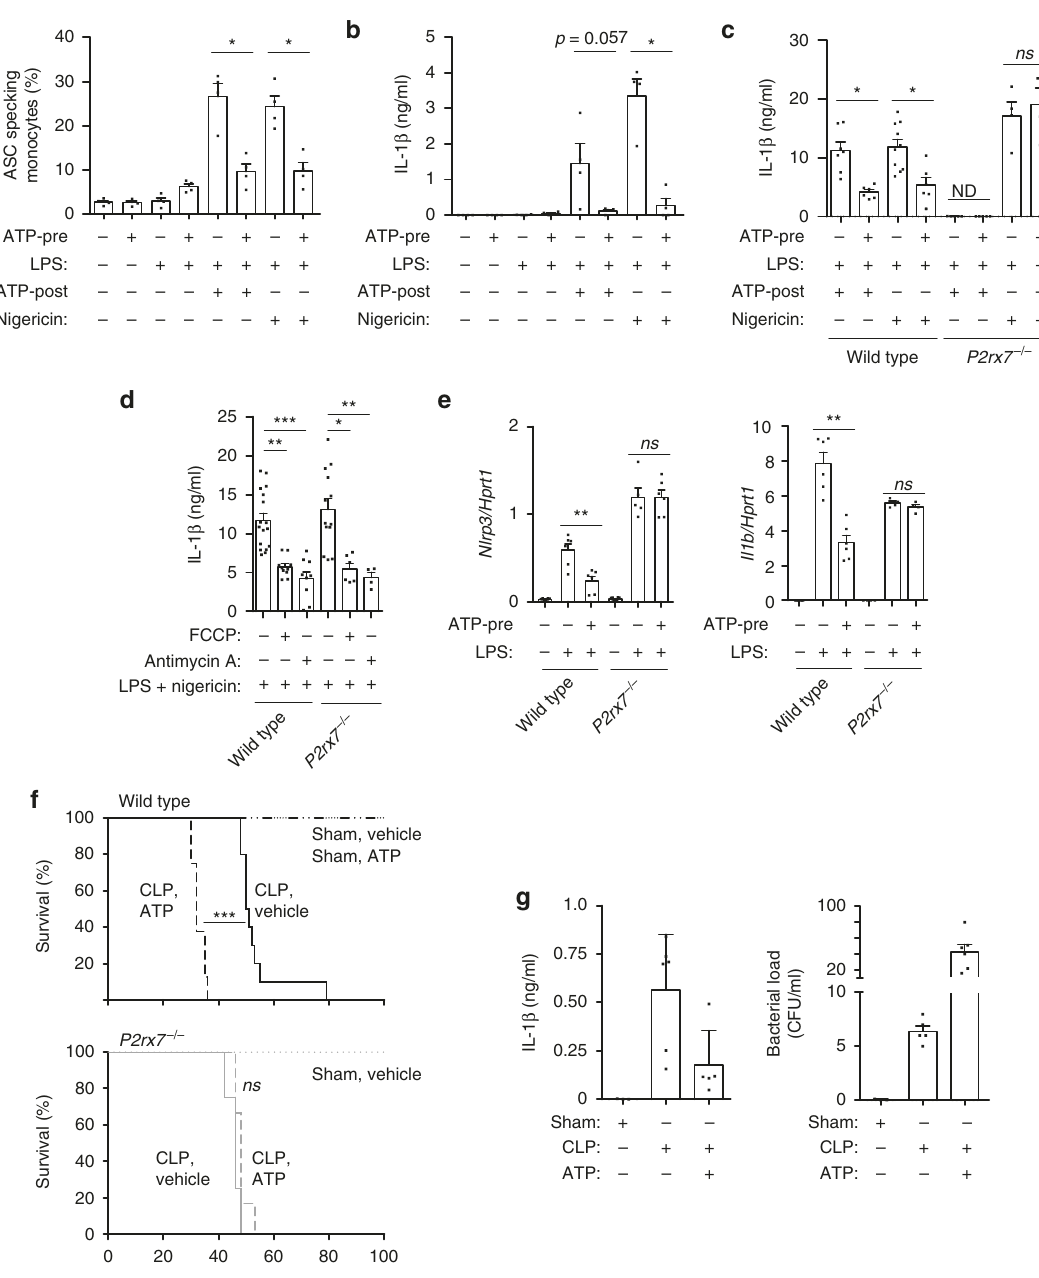
Fig. 6 P2X7 receptor stimulation impairs the NLRP3 in fl ammasome in monocytes. a , b Percentage of monocytes with ASC-specks ( a ) and release of IL-1 β from PBMCs ( b ) isolated from healthy donor blood samples treated with ATP (3 mM, 30 min; ATP-pre), then washed and primed with or without LPS (1 μ g/ml, 2 h) and then treated for 20 min with ATP (3 mM; ATP-post) or nigericin (10 μ M) as indicated. c IL-1 β release from wild type or P2rx7 − / − BMDMs treated as in a , but with 4 h LPS priming and 30 min of ATP or nigericin. d IL-1 β release from wild type or P2rx7 − / − BMDMs treated for 30 min with antimycin A (5 μ M) or FCCP (1 μ M), and then washed and primed with LPS (1 μ g/ml, 4 h) and then stimulated with nigericin (10 μ M, 30 min) as indicated. e Expression of Nrlp3 and Il1b genes analyzed by quantitative PCR from wild type or P2rx7 − / − BMDMs treated with ATP (3 mM, 30 min; ATP- pre), then washed and primed with or without LPS (100 ng/ml, 4 h). f Kaplan – Meier representation of wild type (top) or P2rx7 − / − (bottom) mice survival after sham operation (dotted line), or CLP operation (continuous line); some mice groups were i.p. injected with ATP (0.5 mg/g) 30 min before operation (dashed lines). Wild type CLP n = 10, CLP + ATP n = 8, sham n = 4, sham + ATP n = 4; P2rx7 − / − CLP n = 4, CLP + ATP n = 6, sham n = 3. g IL-1 β from peritoneal lavage (left) or bacterial load in blood (right) from wild type sham, CLP or CLP + ATP mice after 24 h. Each dot represents a single independent experiment ( c , d ), a sample from an individual healthy donor ( a , b , e ) or a single mouse ( g ); average ± standard error is represented in panels a – e , g ; exact n number for each panel is presented in Source Data fi le; * p < 0.05; ** p < 0.01; ns , no signi fi cant difference ( p > 0.05); Mann – Whitney test was used for a , b , d , e ; Kruskal – Wallis test was used for c ; Log-rank test for